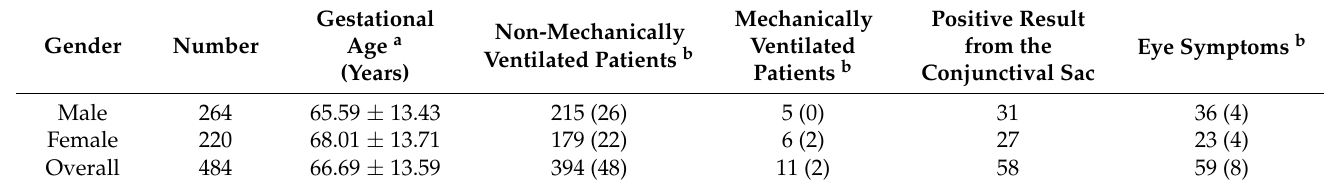
Table 1. The overview of all patients with COVID-19-positive PCR test and the patients with a positive result from the conjunctival sac.